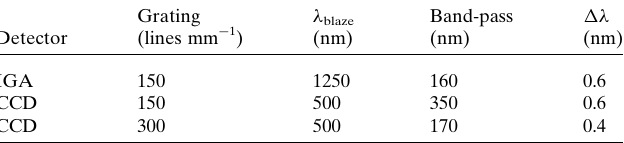
Table 1 Spectrograph band-pass and resolution ( (cid:2) (cid:2) ) for different gratings, where (cid:2) blaze is the blaze wavelength of the grating. The resolution values are indicated for a slit width of 25 m m. Grating Detector (lines mm (cid:2) 1 )